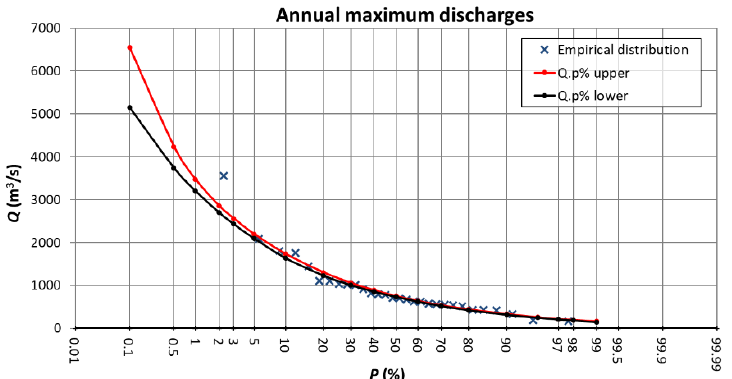
Figure 2. Uncertainty interval for the annual maximum discharges (Rădăuți -Prut gauge station).